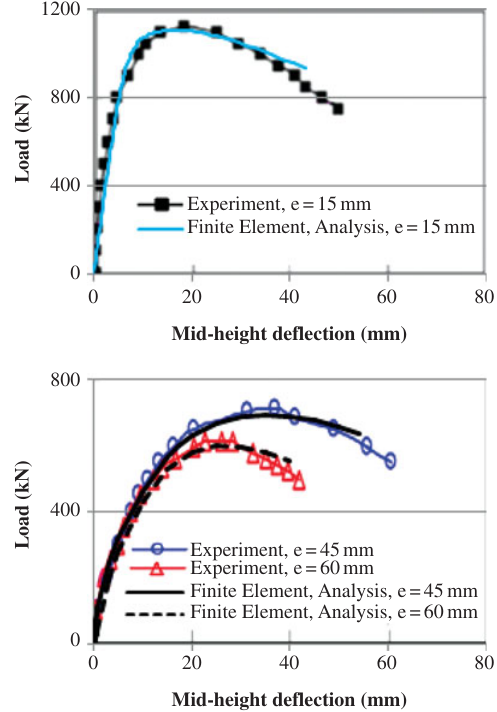
Fig. 4. Load versus mid-height deflection curves for the